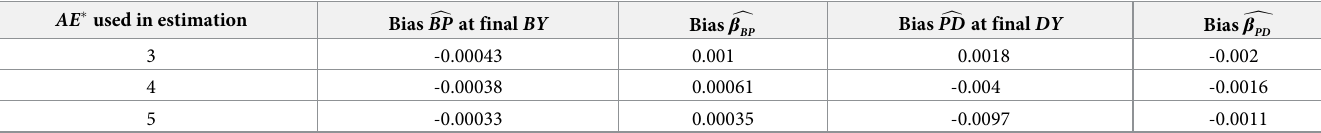
Table 4. Comparison of the effect of the choice of assumed AE � vs. true value of AE = 3, with two unidentified subgroups with different values of probability of diag- nosis, mismatched to analysis. AE � used in